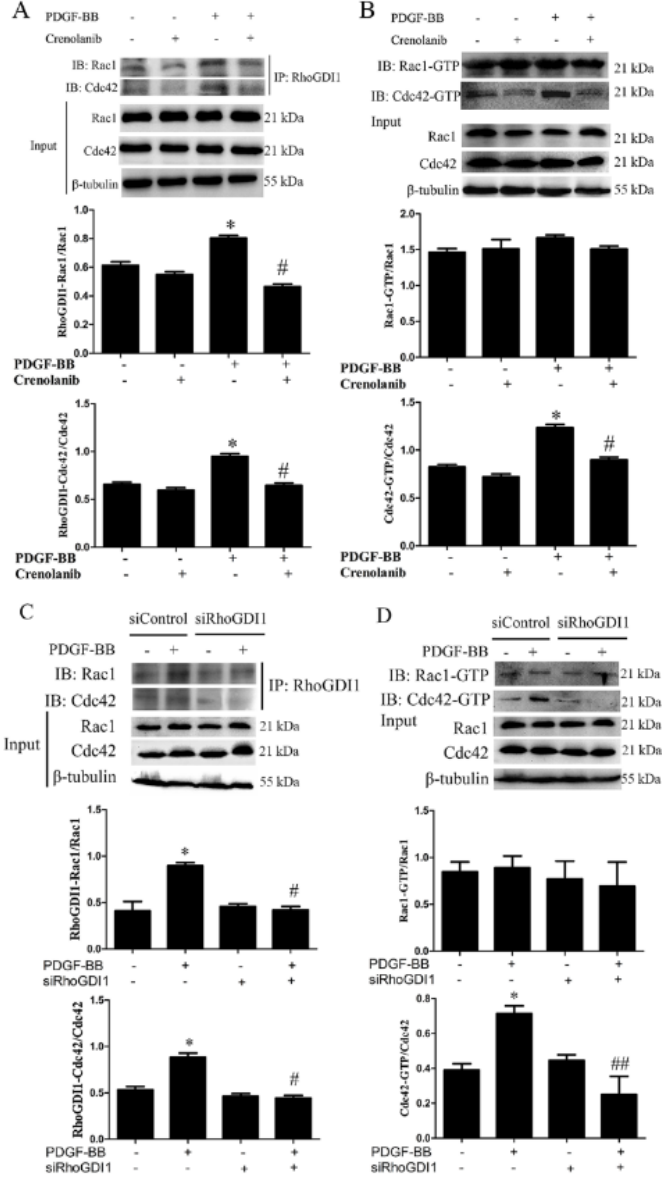
Figure 4. Both crenolanib pretreatment and RhoGDI1 suppression inhibit the activation of Cdc42 and its binding to RhoGDI1. HA-VSMCs were pretreated with crenolanib (50 nM) for 48 h, followed by treatment with 10 ng/mL of PDGF-BB for 24 h. The cells were transfected with control or RhoGDI1 siRNA for 48 h and then treated with 10 ng/mL of PDGF-BB for another 24 h. Untreated cells or cells transfected with control siRNA alone were used as control. ( A and C ) Analysis of the interaction of RhoGDI1 with Rac1 or Cdc42 using Co-IP analysis. RhoGDI1 was immunoprecipitated from the cell lysates using the specific antibodies, and then the immunoprecipitated proteins were analyzed by western blotting. Crenolanib pretreatment and RhoGDI1 suppression inhibited the binding of RhoGDI1 with Rac1 or Cdc42 induced by PDGF-BB. Histograms showing the ratios of RhoGDI1-binding Rac1 or Cdc42 to total Rac1 or Cdc42. *, p < 0.05 vs. the control group; #, p < 0.05 vs. the PDGF-BB-treated group ( n = 3). ( B and D ) Detection of Rho GTPases activity by pulldown assay. Crenolanib pretreatment and RhoGDI1 suppression inhibited PDGF-BB-induced activation of Cdc42 without affecting Rac1 activation. Histograms showing the ratios of Rac1 or Cdc42 GTP-bound to total Rac1 or Cdc42. *, p < 0.05 vs. the control group; #, p < 0.05 and ##, p < 0.01 vs. the PDGF-BB-treated group ( n =